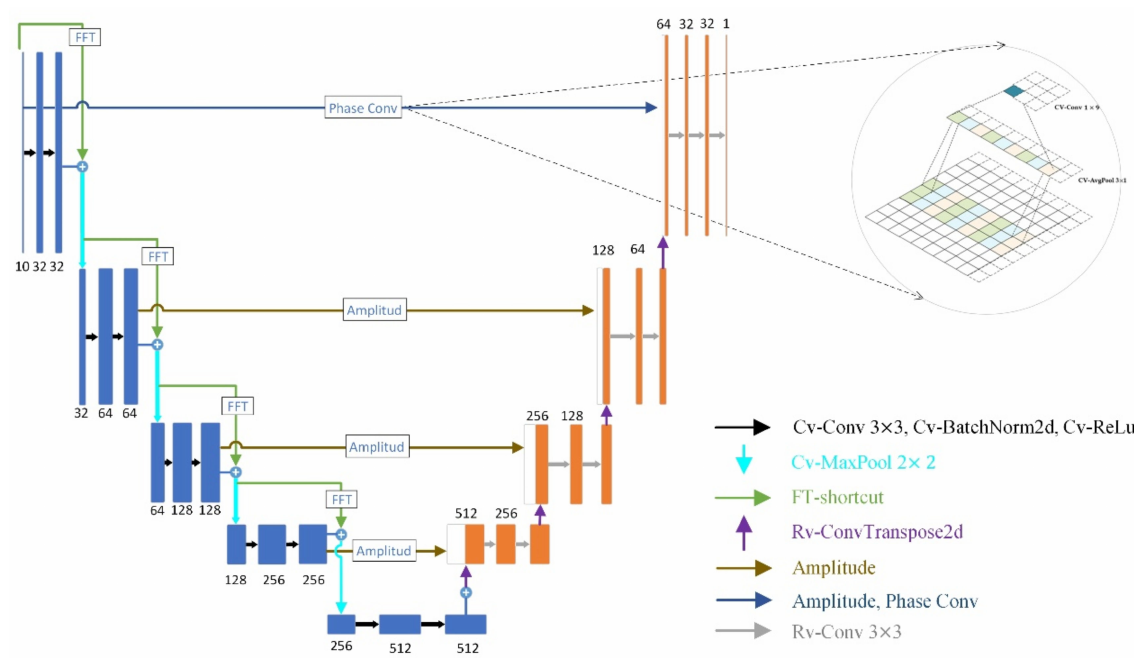
Figure 4. The neural network